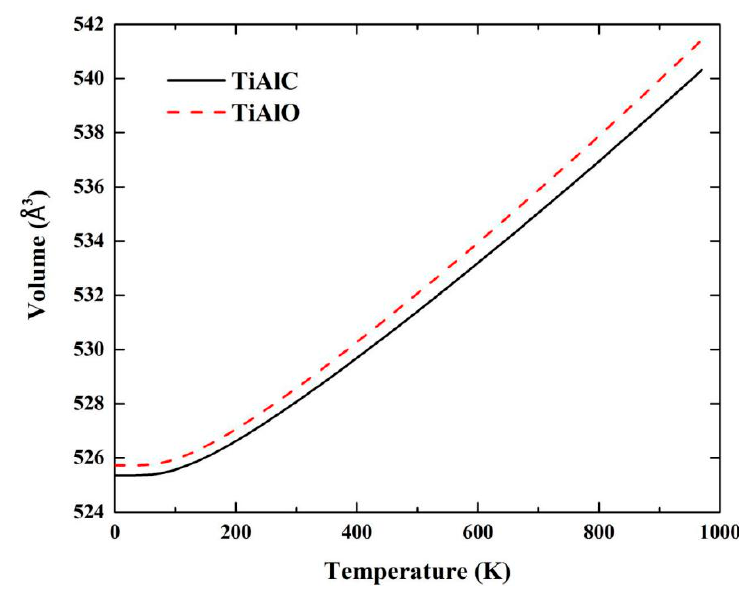
Figure 3. Volumetric expansion as a function of temperature for TiAlC and TiAlO, where the solid line represents TiAlC and the dashed line represents TiAlO.